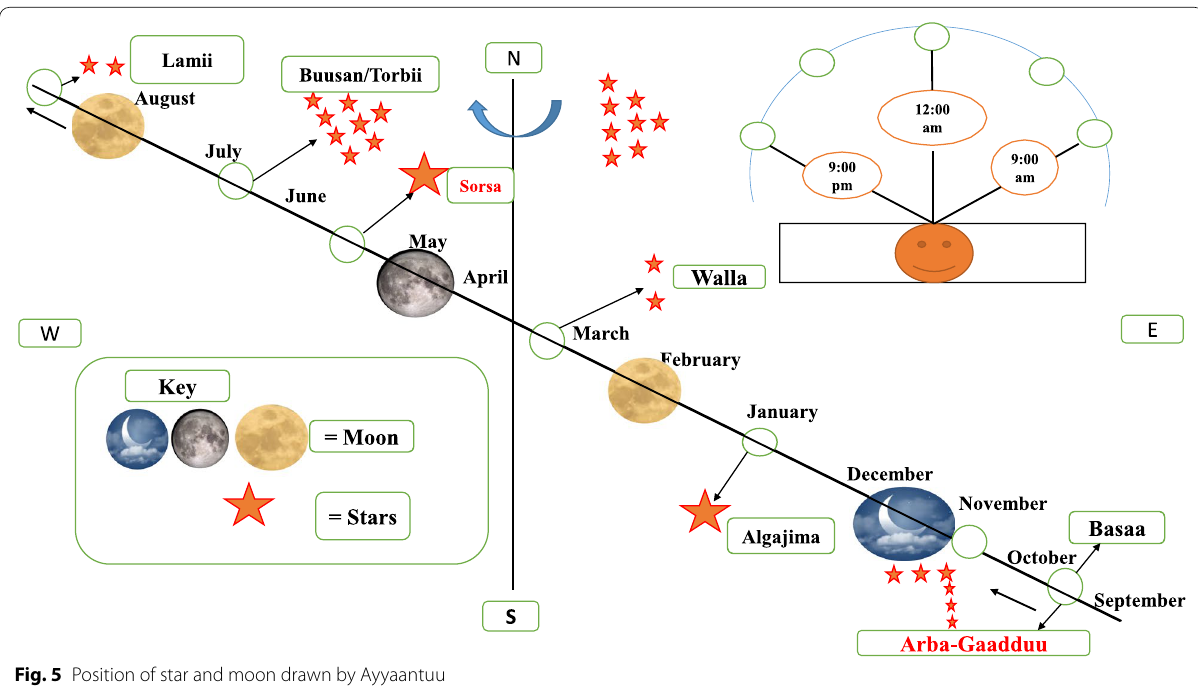
Fig. 5 Position of star and moon drawn by